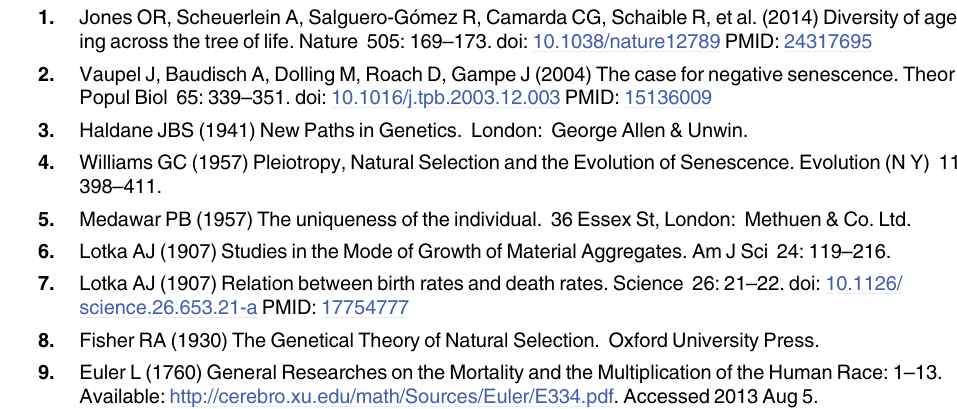
S4 Fig. The selection of constrained genealogical subsets for estimating inclusive fitness. (a) A pattern-matching algorithm found every ith individual in the population with a full set of either parents or grandparents. (b) The direct descendants of all individuals in the population matching these criteria were collected (delimited by dashed line in b-c), creating a delimited sub-graph of the original genealogy. (c) We calculated the coefficient of relatedness r between the ith individual and all of their jth relatives within this sub-graph, and time-sorted the data relative to the ith individual ’ s date of birth. (d) We then measured the sum of r between each ith individual and their jth relatives across all periods from t = 0 to tx , where t = 0 is the earliest birth in the sub-graph and tx ranges from the birth of the ith individual to the last population census. This gave us our EGO measure of inclusive fitness over time. S5 Fig. The relationship between the EGO-predicted probability of mortality and the ob- served probability of mortality across increasing census ages in the Agta population. At birth, EGO is not significantly correlated with the age-specific probability of mortality ( p > 0.01). As time since birth increases to t > 30, both parental (a) and grandparental EGO (b) begin to closely approximate the age-specific probability of mortality ( p < 0.01; r > 0.8), de- spite considerable reductions in sample size.